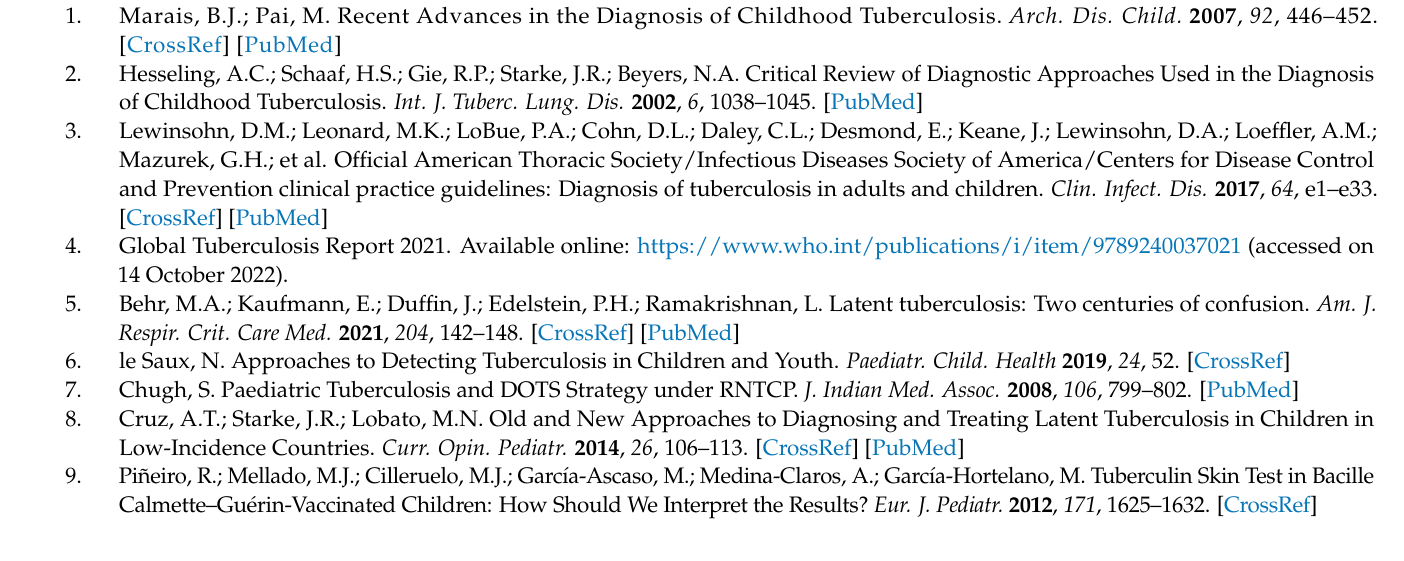
disease; Figure S1. The mean level of IFN- γ produced by leukocytes following stimulation with M.tb antigens in TB1 (white bars) and TB2 (gray bars) QuantiFERON TB Plus whole-blood cultures in the groups of TB contact and no TB contact volunteers with negative (TST − ) or positive (TST+) reaction to tuberculin; Figure S2. Mean levels of IFN- γ produced by leukocytes after stimulation with M.tb antigens in TB1 (white bars) and TB2 (gray bars) QuantiFERON TB Plus whole-blood cultures in the groups of volunteers with negative (TST − ) or positive (TST+) reaction to tuberculin by age group; Figure S3. Correlation between IFN- γ levels produced by leukocytes after stimulation with M.tb antigens in TB1 (A) and TB2 (B) QuantiFERON TB Plus whole-blood cultures and TST induration